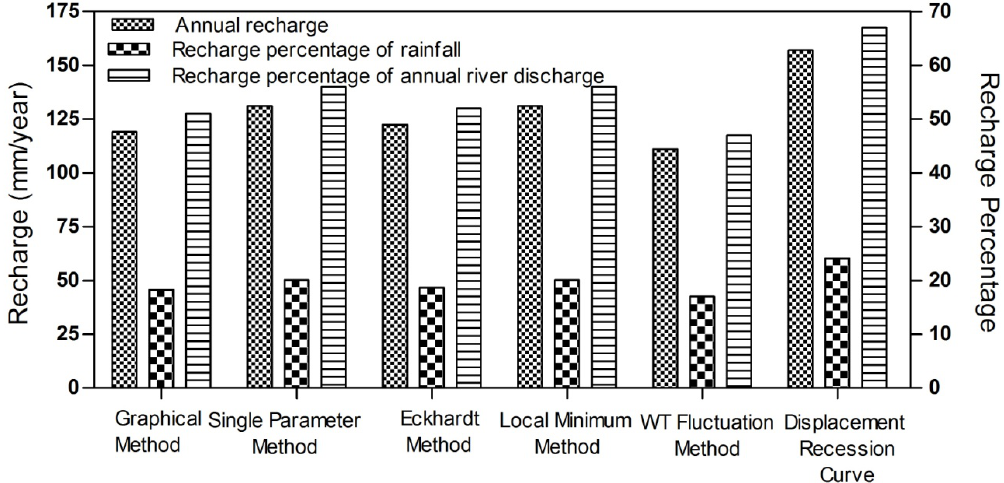
Figure 9. Estimated recharge using the base-flow separation methods (graphical method, single parameter method, Eckhardt method, local minimum method), WT fluctuation method and displacement recession curve